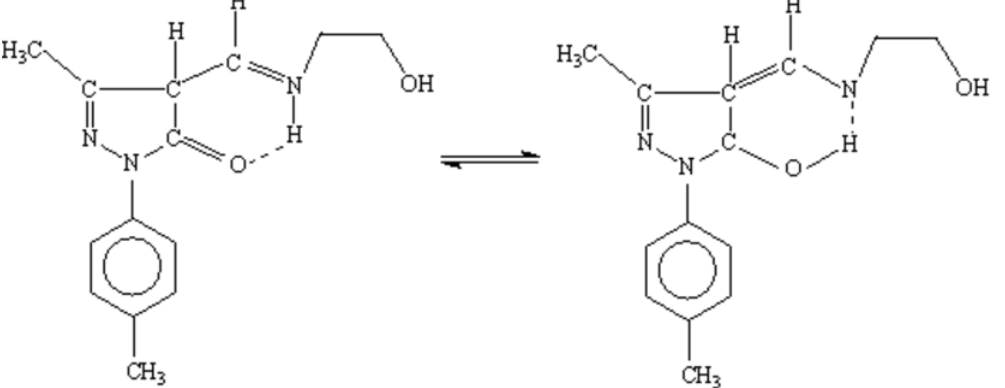
Figure 1. Tautomerism between imine-ol and amine-one